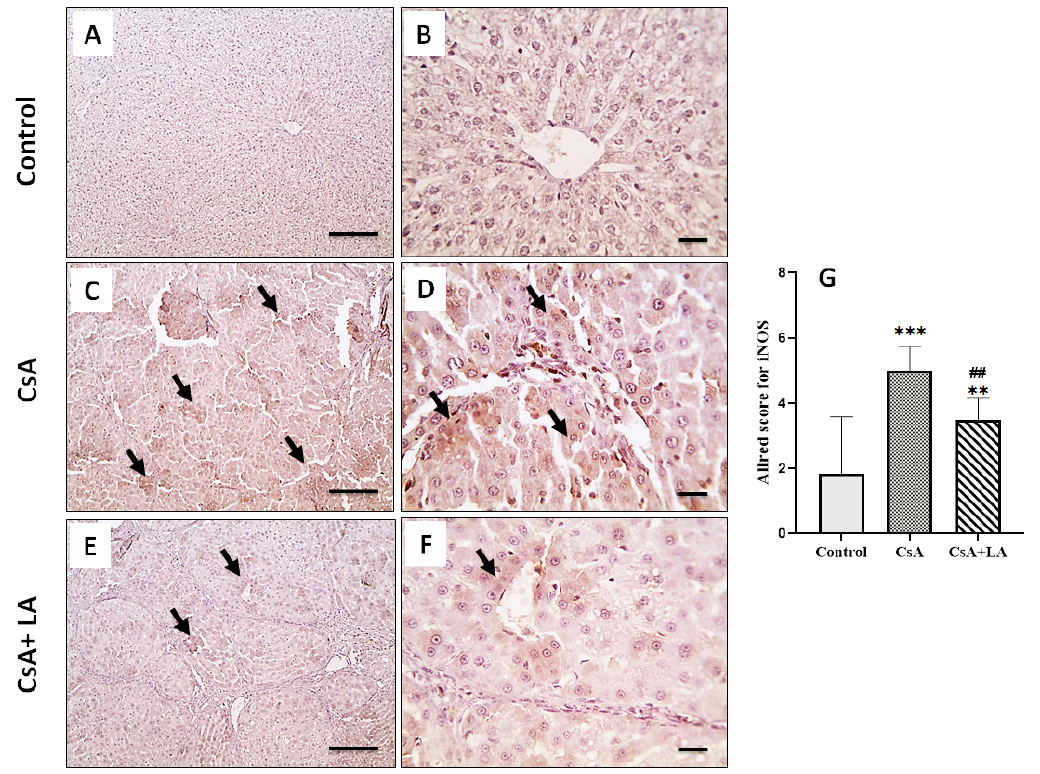
Figure 6. Microscopic pictures of immunostained hepatic sections against iNOS. The control normal group ( A , B ) shows negatively stained hepatocytes. Hepatic sections ( C , D ) from the CsA-treated group show markedly increased positively stained hepatocytes (arrows). Hepatic sections ( E , F ) from the (CsA + LA) treated group show significantly decreased numbers of positively stained hepatocytes (arrows). IHC counterstained with Mayer’s hematoxylin, ( A , C , E ; Scale bar = 100 μ m), and ( B , D , F ; Scale bar = 50 μ m). ( G ) represents the Allred score for iNOS cellular expression. Data are expressed as mean ± SE ( n = 8). *** p < 0.001, ** p < 0.01 versus the control group, ## p < 0.01 versus the CsA group. Allred index (0–1 = negative, 2–3 = mild, 4–6 = moderate, and 7–8 = strongly positive).